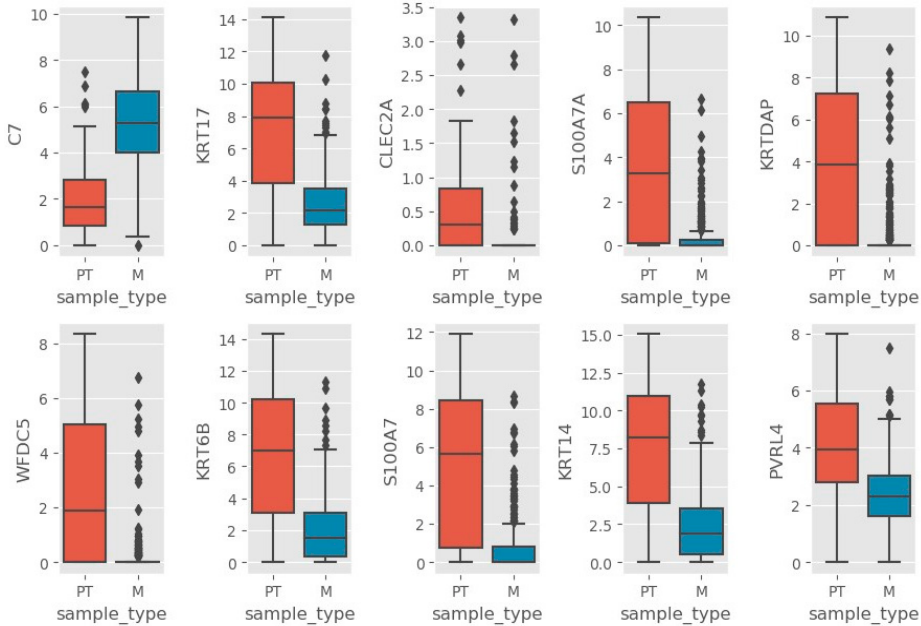
Figure 2. Box plots of Top 10 gene expressions. M refers to metastatic and PT refers to primary tumor. Table 2. Upregulated genes according to sample type from among the 139 feature selected genes. Primary